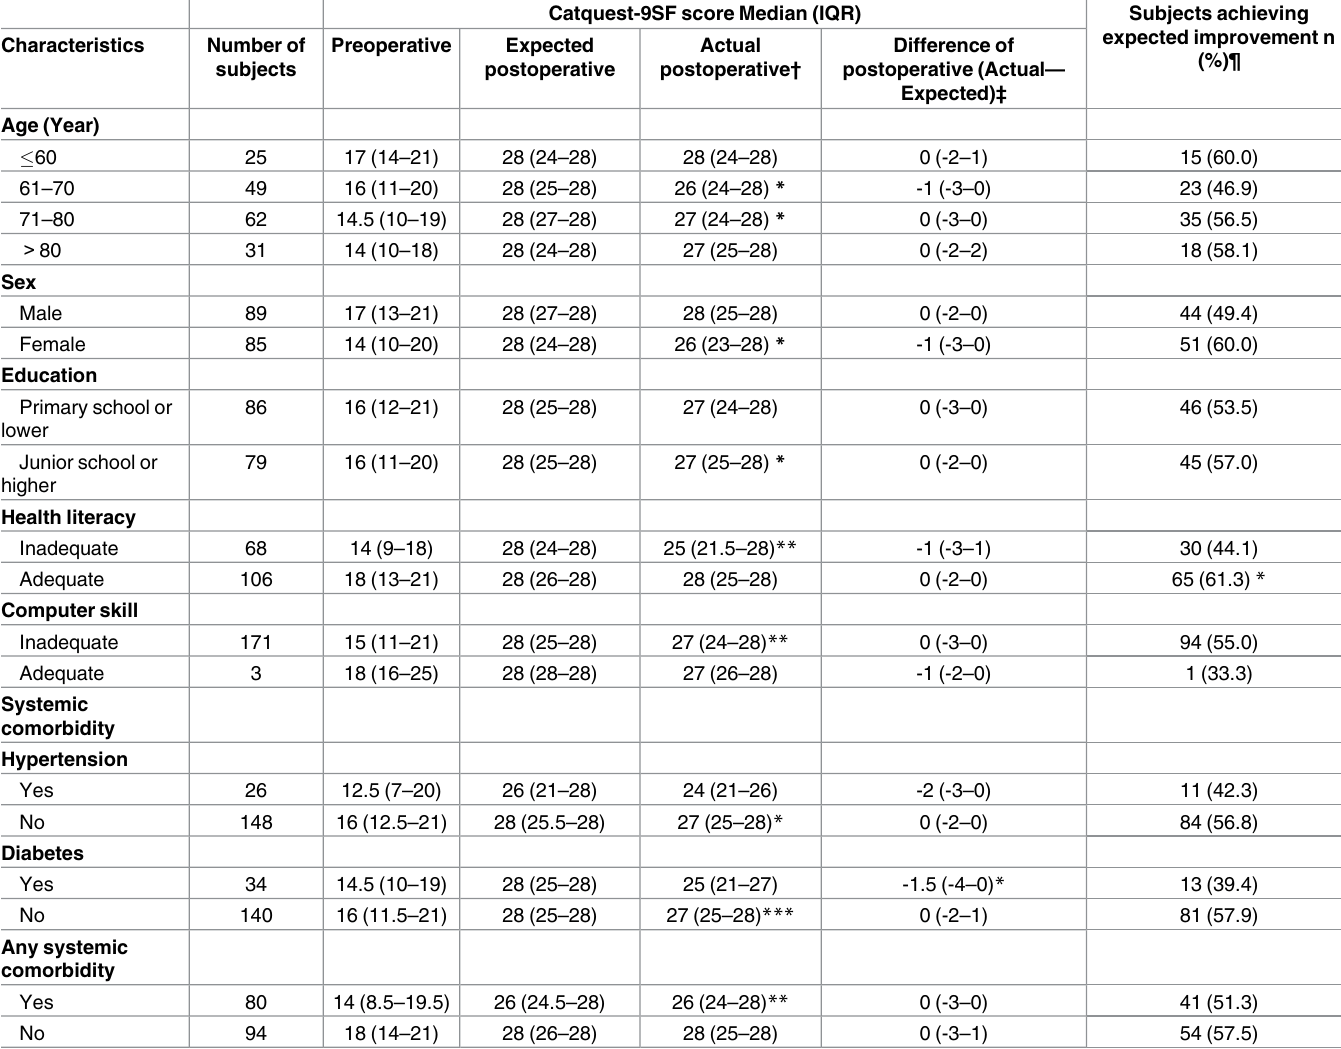
Table 2. Preoperativedifficulty, expected and actual postoperative improvement on the Catquest-9SF items by demographics (N =